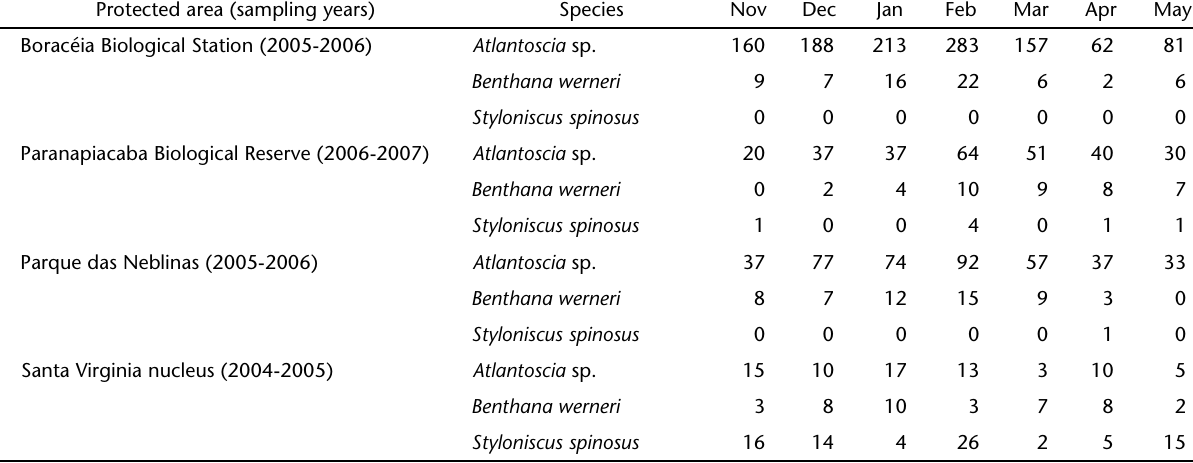
Table III. Abundance of Atlantoscia sp., B. werneri , and S. spinosus over time at the four protected areas. Protected area (sampling years) Species Boracéia Biological Station (2005-2006) Atlantoscia sp.